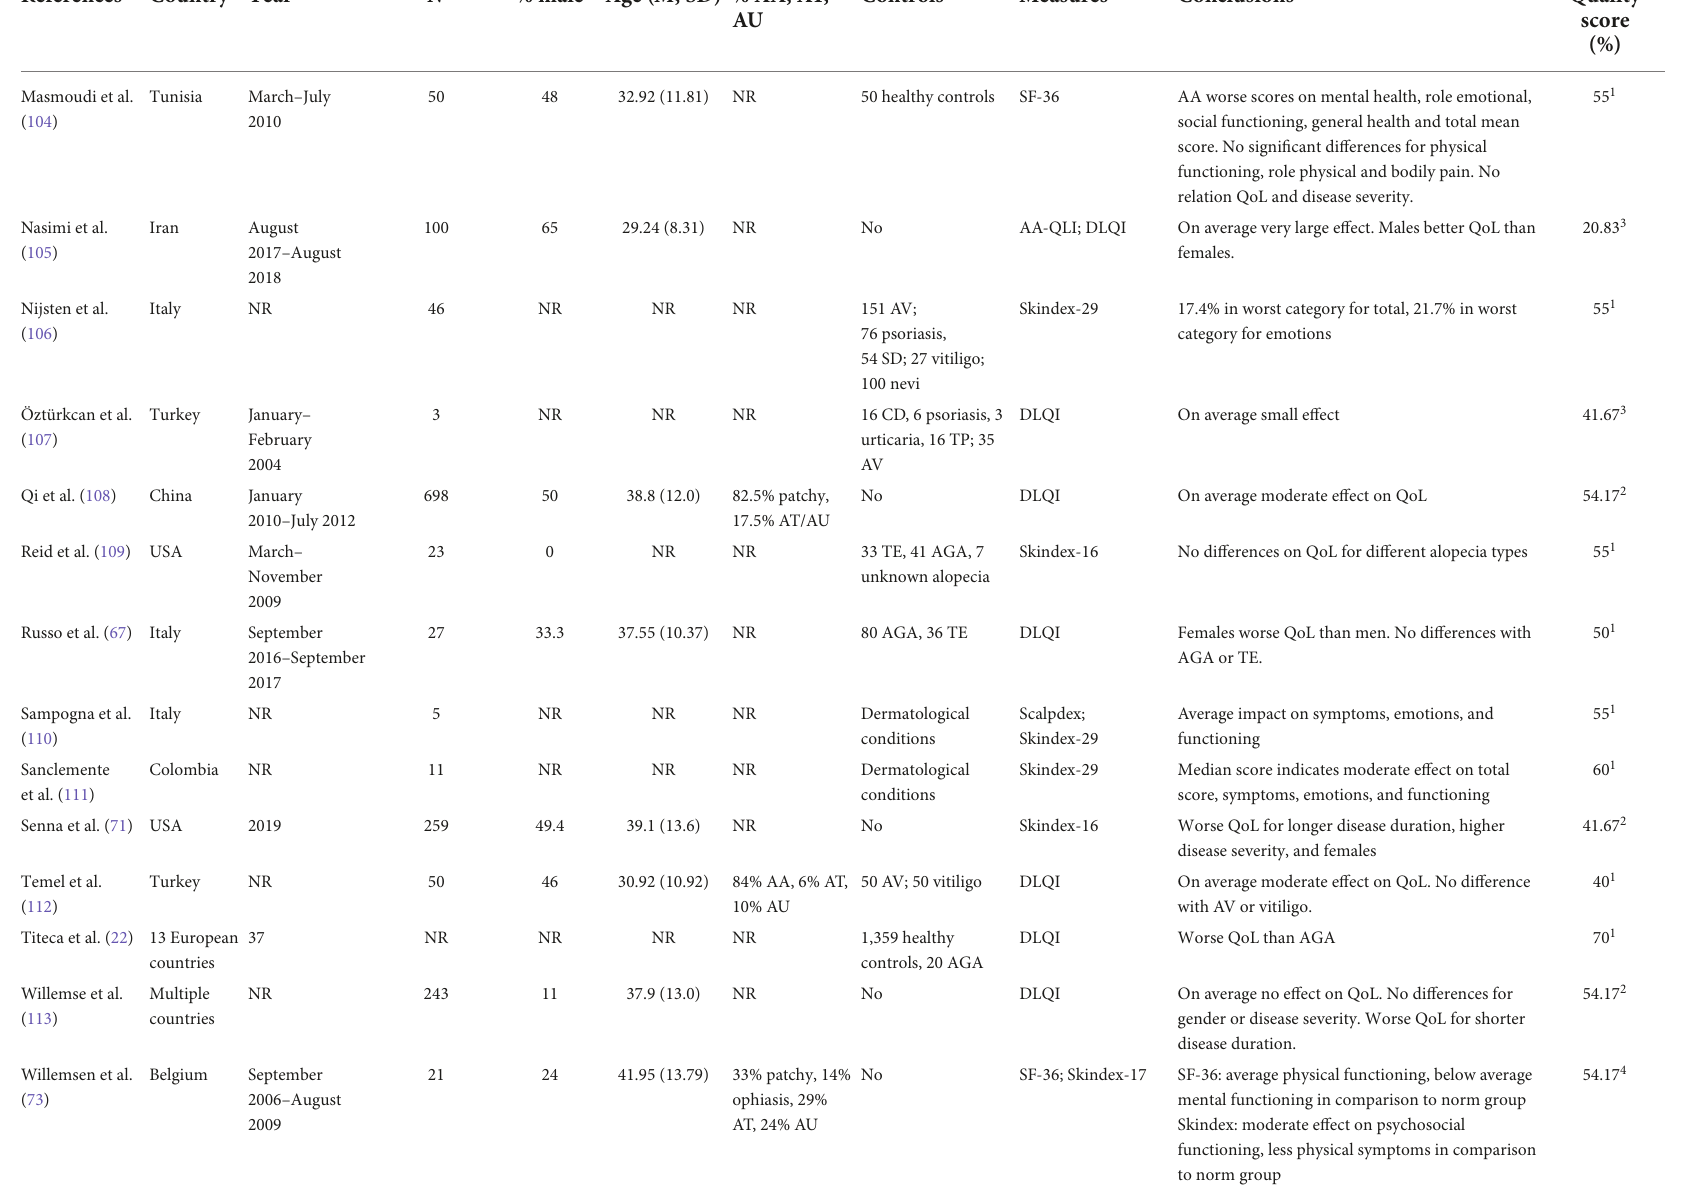
DLQI On average no effect on QoL. No differences for gender or disease severity. Worse QoL for shorter disease duration. SF-36: average physical functioning, below average mental functioning in comparison to norm group Skindex: moderate effect on psychosocial functioning, less physical symptoms in comparison to norm